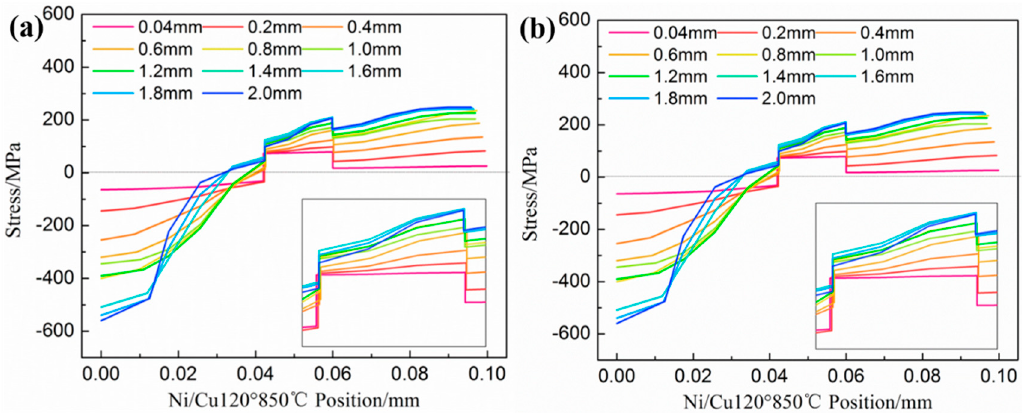
Figure 11. Transverse stress distribution under punch angle 120° and annealing temperature 850 °C ( a ) Ni / Cu, and ( b ) Cu / Ni.